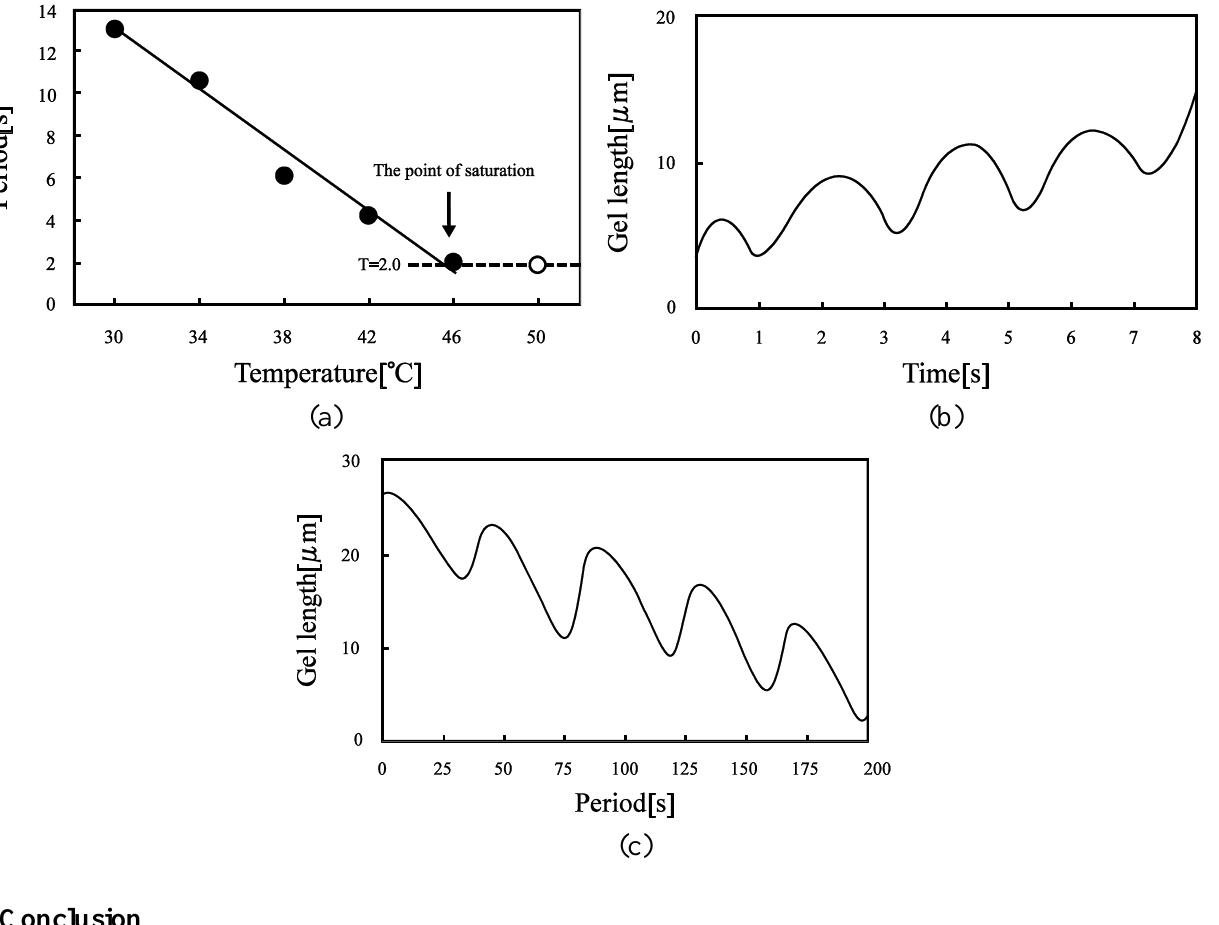
Figure 9. ( a ) Dependence of the self-oscillation period on the temperature. (●) plots and (○) plots show the linear relation and the saturated line vs . temperature, respectively. ( b ) Self-oscillating profile of cubic poly(VP- co -Ru(bpy) ) gel at 50 °C (MA = 0.08 M, 3 NaBrO = 0.48 M and HNO = 0.48 M). ( c ) Self-oscillating profile of cubic poly(VP- co - 3 3 Ru(bpy) ) gel at 20 °C (MA = 0.08 M, NaBrO = 0.48 M and HNO = 0.48 M). Cubic gel 3 3 3 (each side length is about 2 mm and 20 mm) was immersed in 8 mL of the mixture solution of the BZ substrates. Reprinted from Ref. [33] with permission; © The